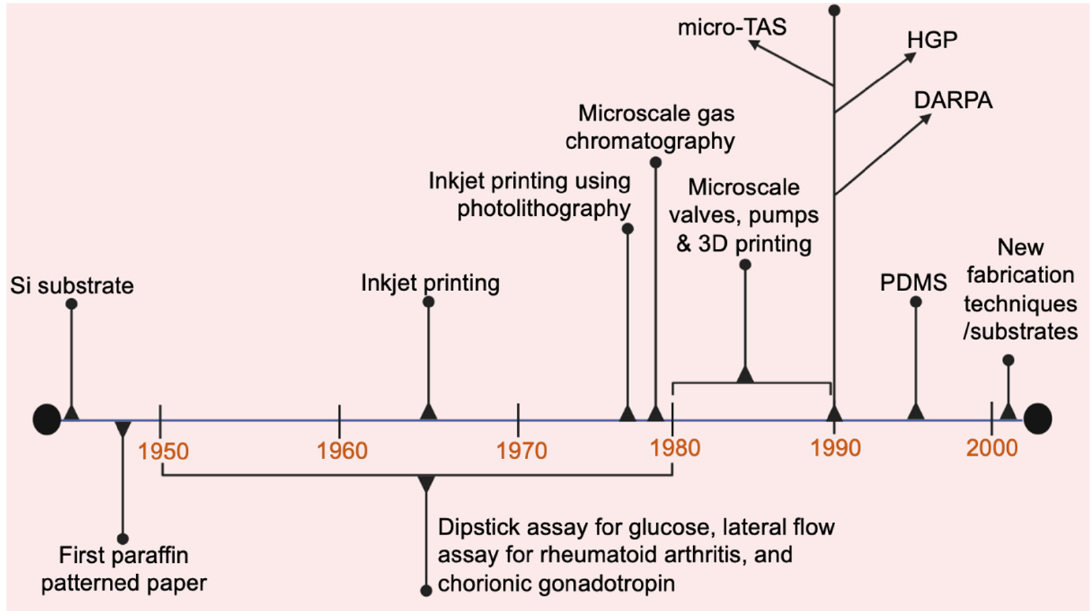
Figure 3. A roadmap highlighting the evolution of microfluidic technologies. Created using BioRender.com. Micro Total Analysis System is abbreviated as Micro TAS, HGP is Human Genome Project and Defence Advanced Projects Research Agency project is abbreviated as DARPA and poly(dimethylsiloxane) as PDMS.